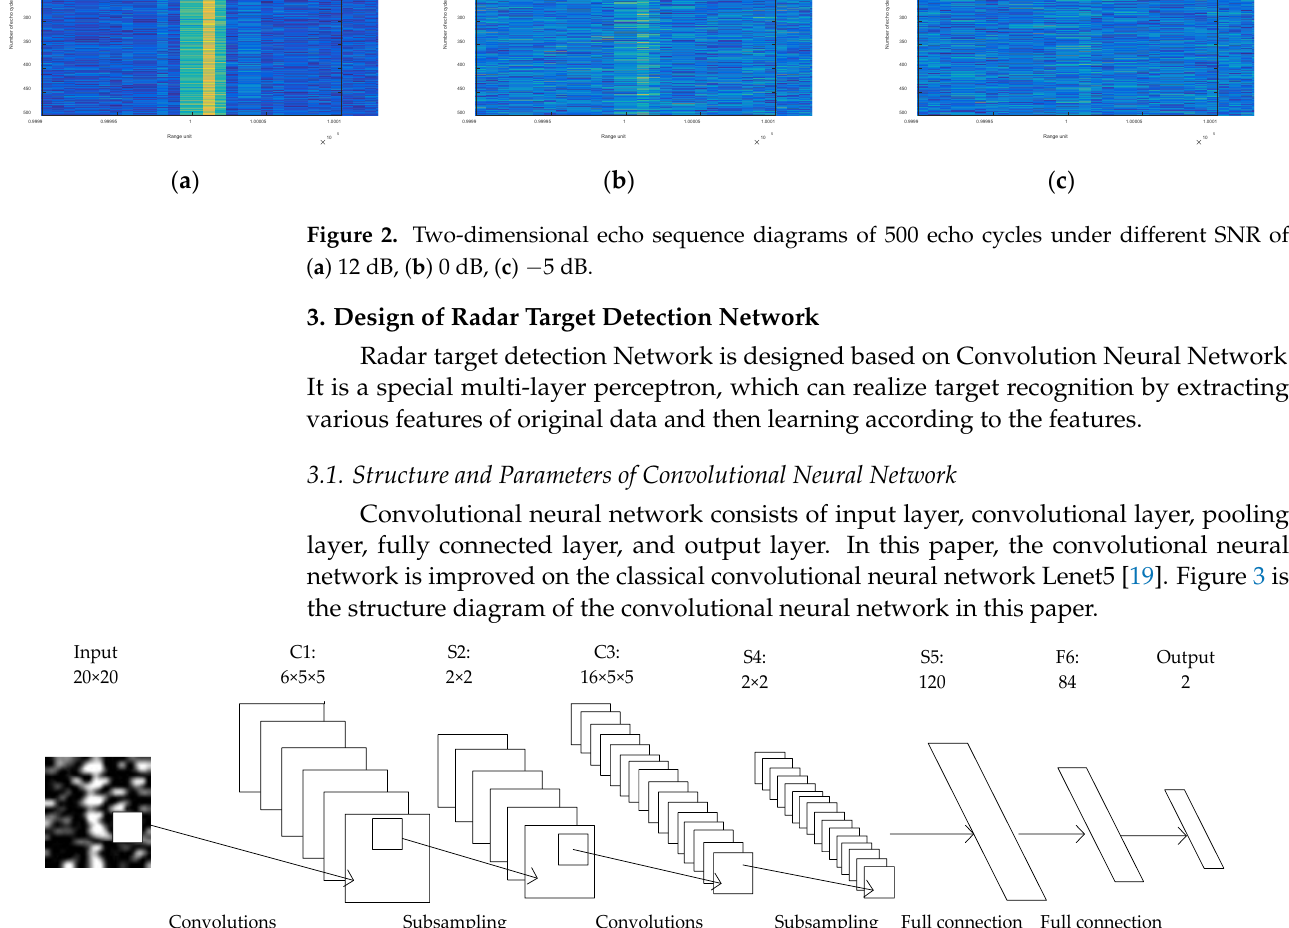
( c ) Figure 4. Convolutional neural network ( a ) input image, ( b ) amplitude value, and ( c ) convolution kernel. The first element of the convolutional neural network is in the upper left corner in Figure 4b; in the first step, the convolution kernel of Figure 4c is used, it is overlayed on the input image, as shown in Figure 5a, and then the element multiplication operation is performed. Finally, the first convolution result element is obtained by adding each ele- ment of the matrix. Then the convolution operation is performed in turn, and the last convolution result as shown in Figure 5e.